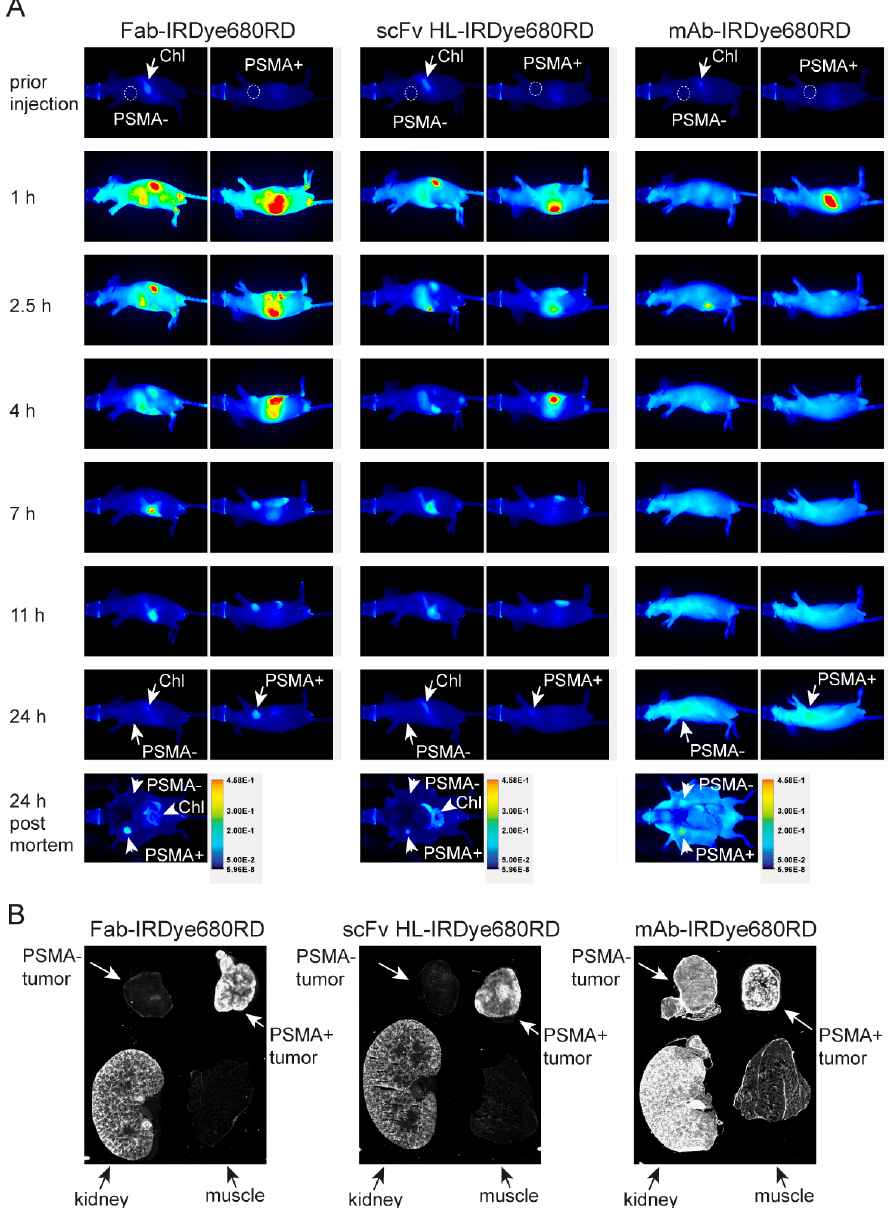
Figure 5. Pharmacokinetics of 5D3 variants and ex vivo NIRF imaging. ( A ) Mice bearing a PSMA- positive (PSMA+, right side) and PSMA-negative (PSMA − , left side) xenograft (location of tumor marked by dashed circle), were intravenously injected with 5D3 variants conjugated to IRDye680RD and images collected at various times post-injection with identical exposure settings. Both Fab and scFv fragments revealed specific localization to the PSMA-positive tumor already after 2.5–4 h p.i., while non-specific binding was still observed for 5D3 mAb at 24 h p.i. due to high levels of the circulating conjugate. At 24 h p.i. mice were sacrificed, and the ventral part dissected, and mice were scanned. The fluorescent signal in the gastrointestinal tract originates from chlorophyll (Chl) present in feed. Figures are representative images from triplicate runs for each 5D3 variant. ( B ) Sections of tumors, kidney and skeletal muscle (24 h p.i.) were scanned ex vivo. The specific signal for scFv and Fab was localized mainly to the rim of PSMA-positive tumors and to the kidney whereas PSMA-negative tumors and skeletal muscle did not show any significant signal. 5D3 mAb showed a strong signal in both tumors as well as kidney, and also observable signal in the PSMA-negative tumor and skeletal